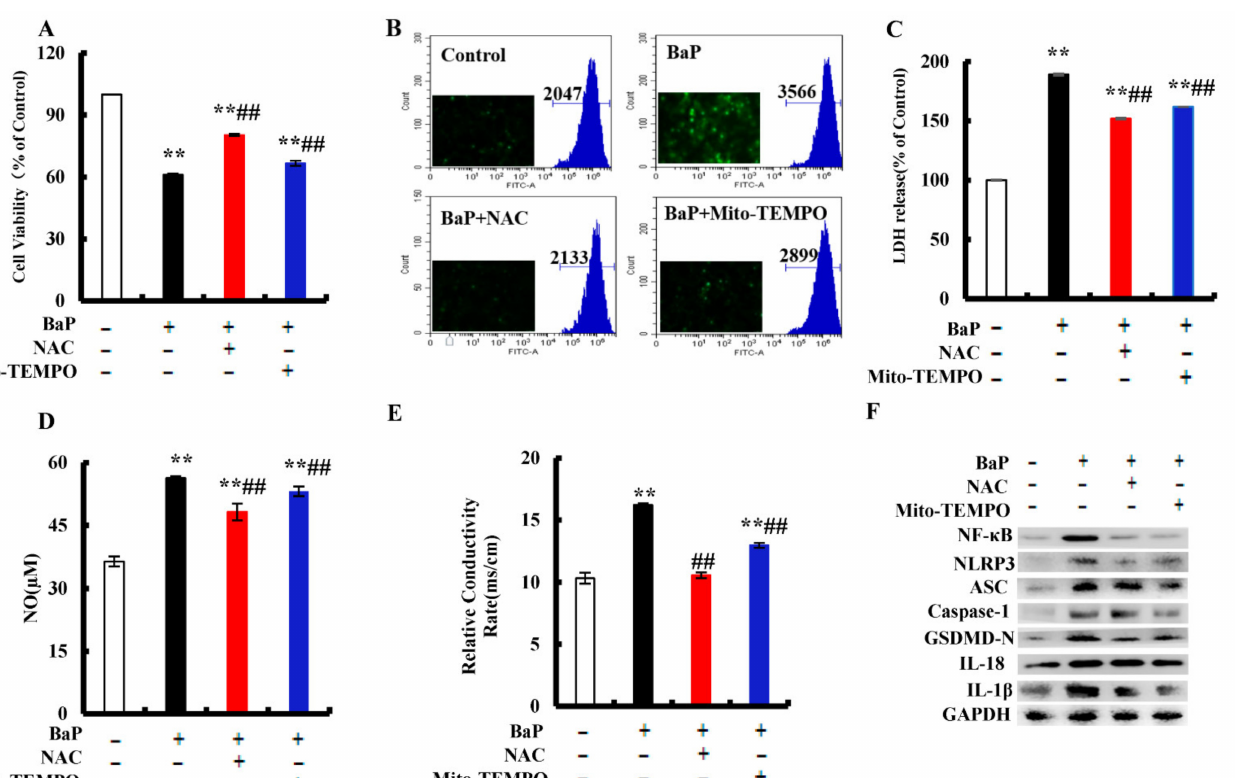
Figure 6. Effects of ROS inhibitor (NAC, 2 mM) and mtROS inhibitor (Mito-TEMPO, 50 µ M) on BaP-induced pyroptotic hepatocyte damage. Cell viability ( A ), LDH ( C ), NO ( D ), and electrical conductivity ( E ) were detected. ** p < 0.01 compared with control, ## p < 0.01 compared with 25 µ M BaP. ROS were examined by Flow cytometer and Fluorescence microscope ( B ). Western blot image of protein expression acquired by Chemical XRS Imaging System ( F